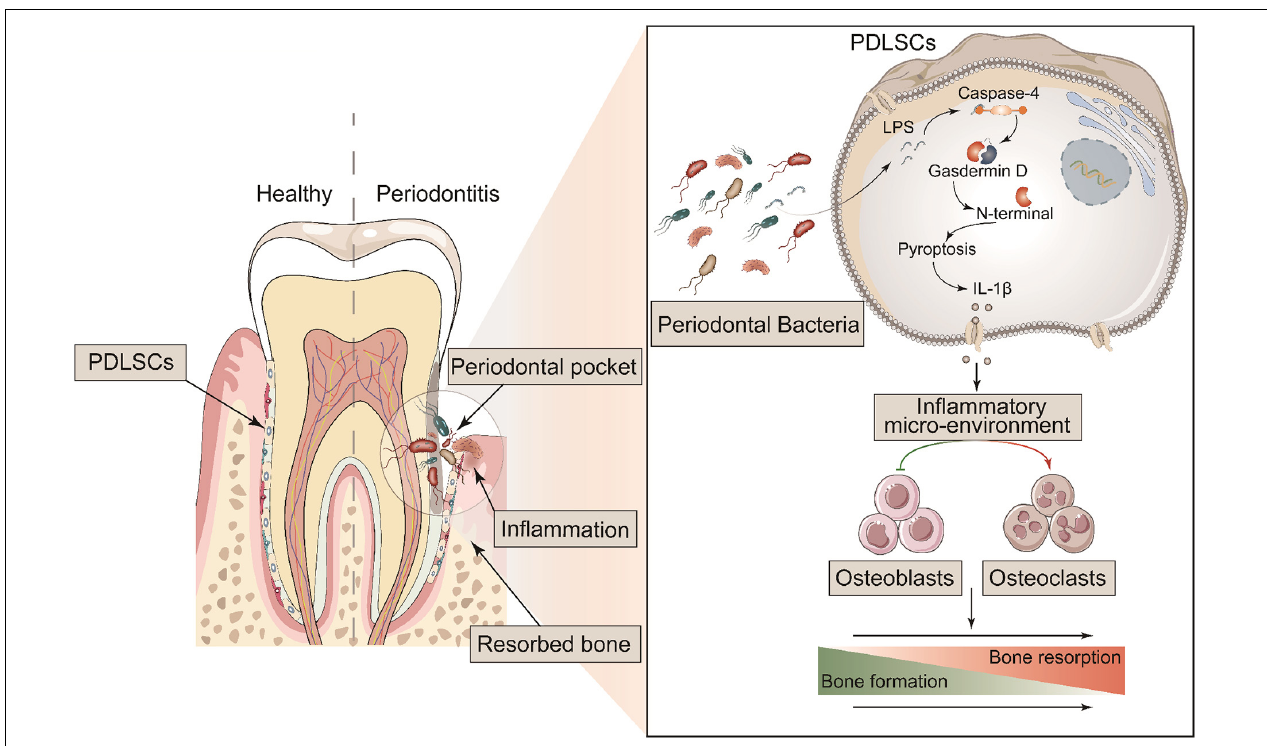
FIGURE 8 | Schematic diagram of the mechanism of GSDMD-mediated PDLSC pyroptosis in the promotion of periodontitis. PDLSCs commit Caspase-4/GSDMD-mediated non-canonical pyroptosis in periodontopathogen-induced periodontitis. The pyroptotic PDLSCs express IL-1 β and release it to the cellular microenvironment following membrane rupture. IL-1 β disrupts the homeostatic balance of bone formation and resorption by inhibiting osteoblastogenesis and promoting osteoclastogenesis, jointly aggravating the process of